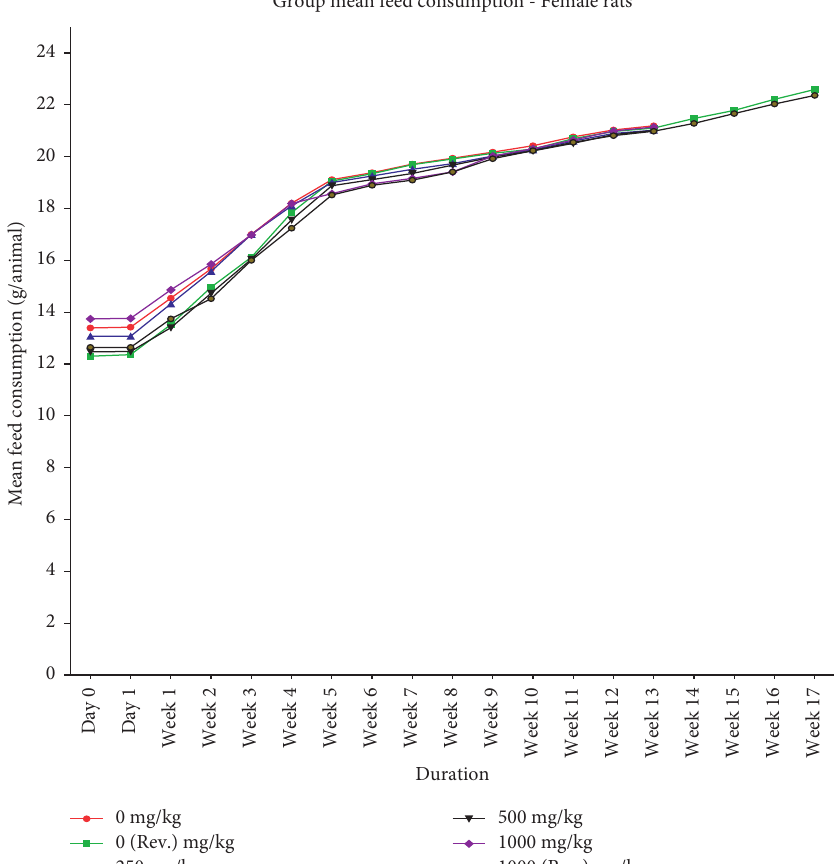
Figure 4: Group mean feed consumption (mean ± SD) of female rats orally administered with GutGard for 90 days ( n � 10; n � 5 for reversal groups; p ≤ 0 . 05). Table 3: Effect of GutGard on haematological parameters of male rats during 90D oral toxicity study.